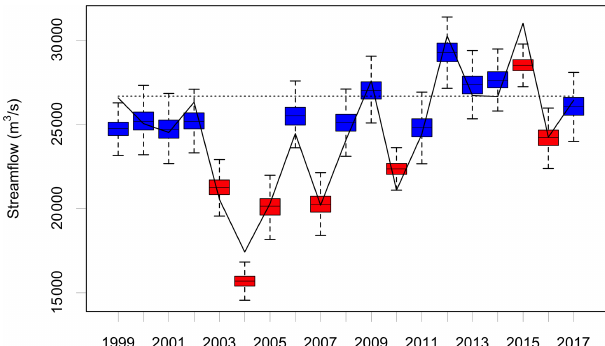
Figure 4. Marañón River at San Regis MAM streamflow hindcast using the statistical prediction model. The black solid line illustrates observed MAM streamflow; the black dotted line indicates the 80th percentile of MAM observed streamflow. Red (blue) boxes repre- sent years with preseason El Niño (La Niña) conditions.